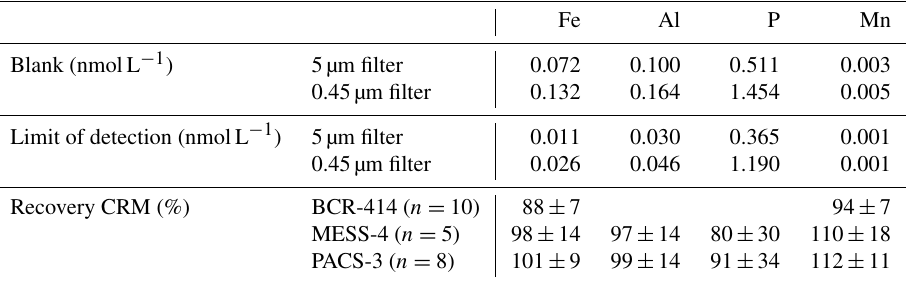
Table 1. Blank and limit of detection (nmolL − 1 ) of the two filters and certified reference material (CRM) recoveries during GEOVIDE suspended particle